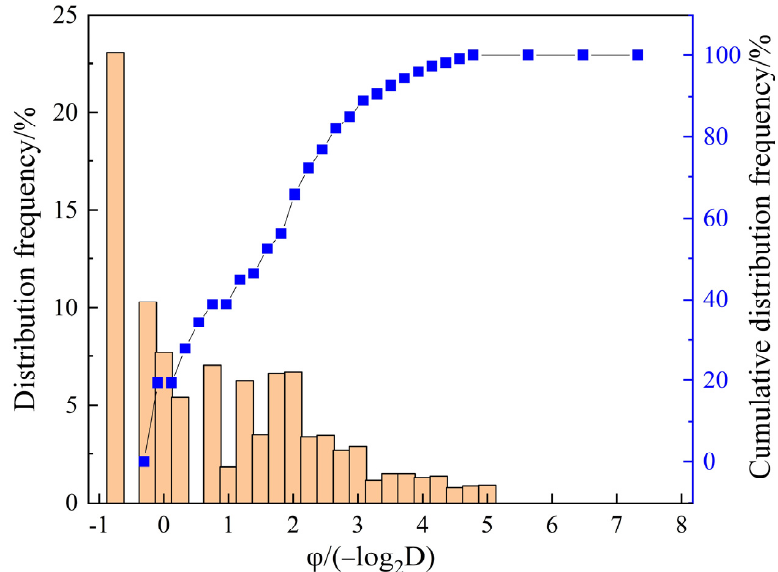
Figure 2. Particle size distribution. D indicates the particle size, φ is the common particle size unit for particle size analysis, and the relationship between the two can be expressed by the equation: φ = − log 2 D. The rock interior has the highest percentage of coarse sand content, followed by medium sand, and the lowest content of silt sand.